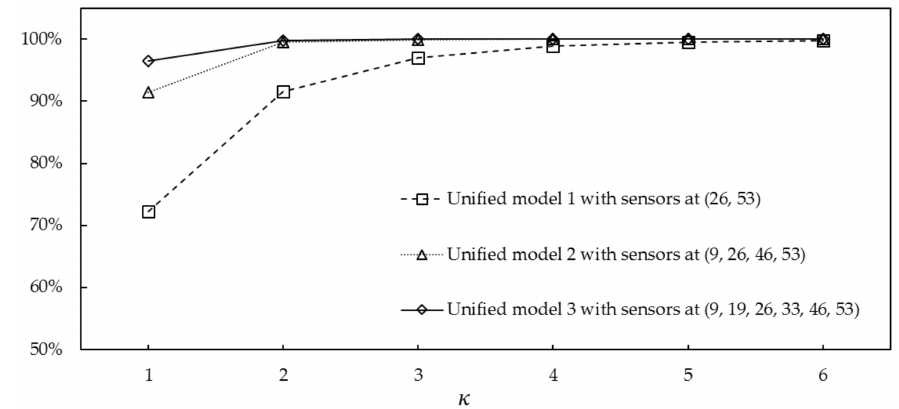
Figure 11. Percentage that the correct spill location is included by the top κ locations with respect to the ranking of the value P i ( d )